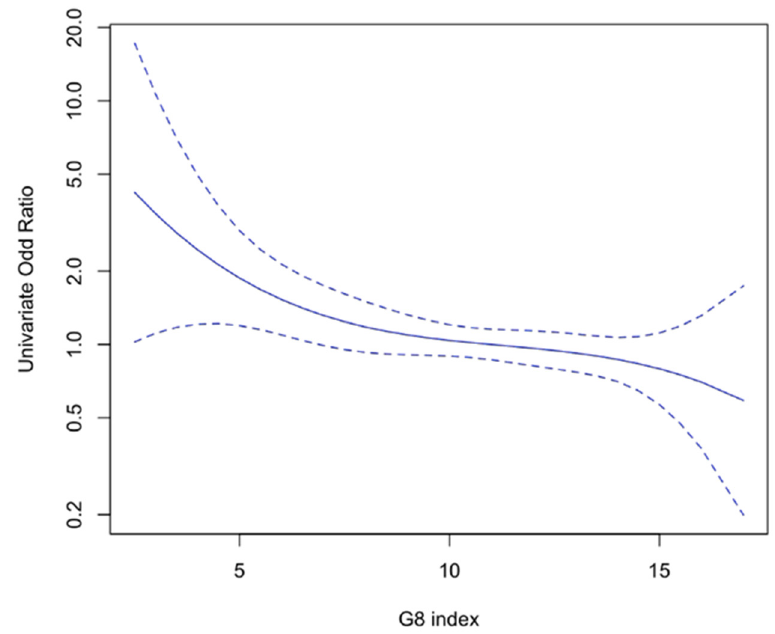
Figure 2. Linear association between the G8 index and CAR cluster B among elderly cancer patients.